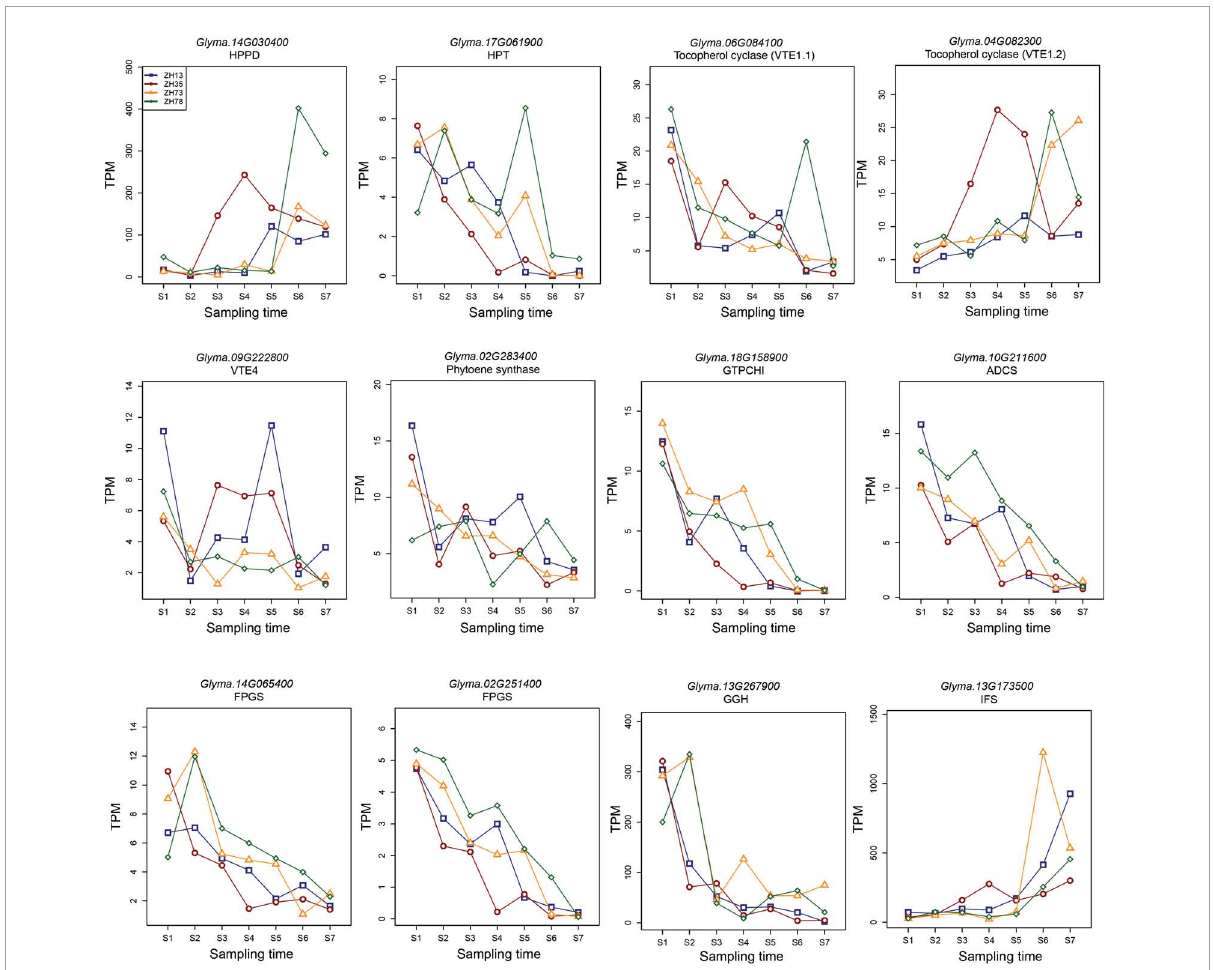
FIGURE4 Expression of key biosynthesis enzymes for tocopherol, carotenoid, folate, and isoflavone during seed development in soybean. Sampling times, S1–S7 represent the different sampling time points in sequential order and S1 corresponds to the R5 stage of soybean seed development, while S7 corresponds to the mature